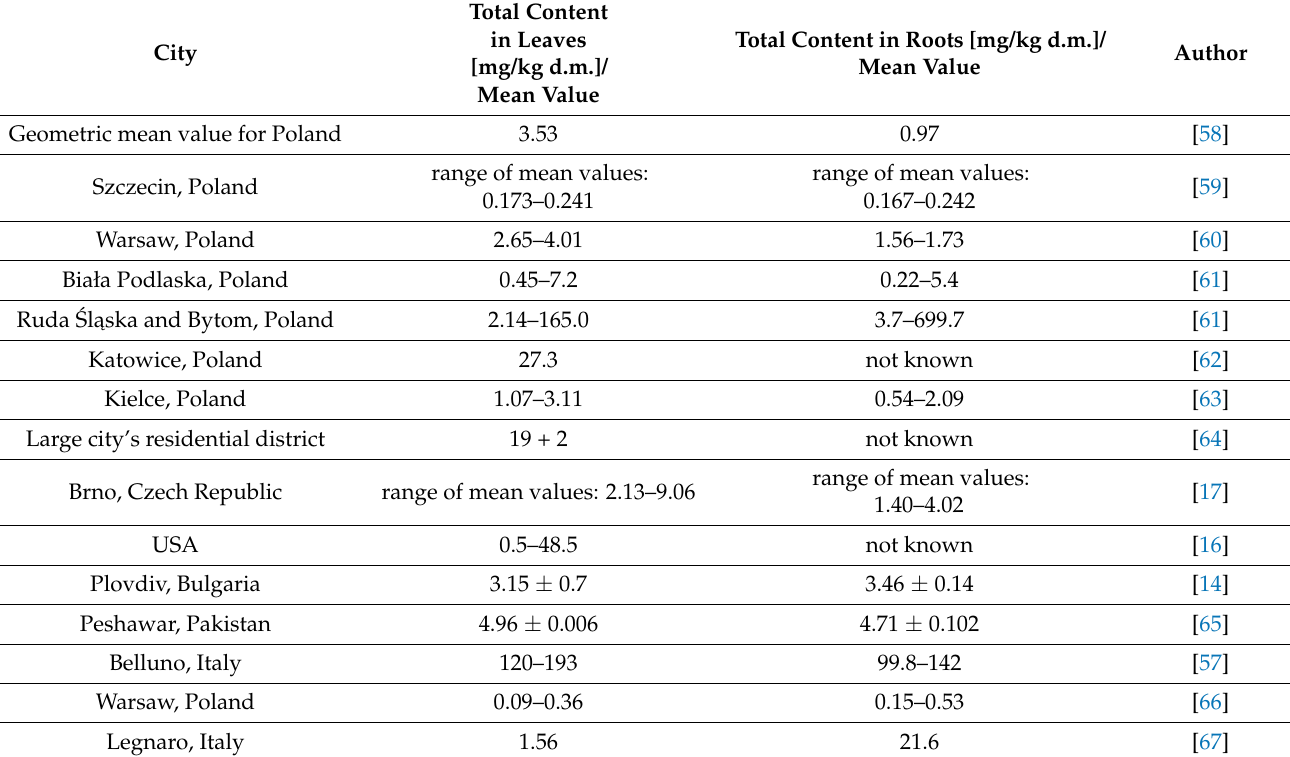
Table 8. Diversification of lead content in the common dandelion’s roots and leaves.